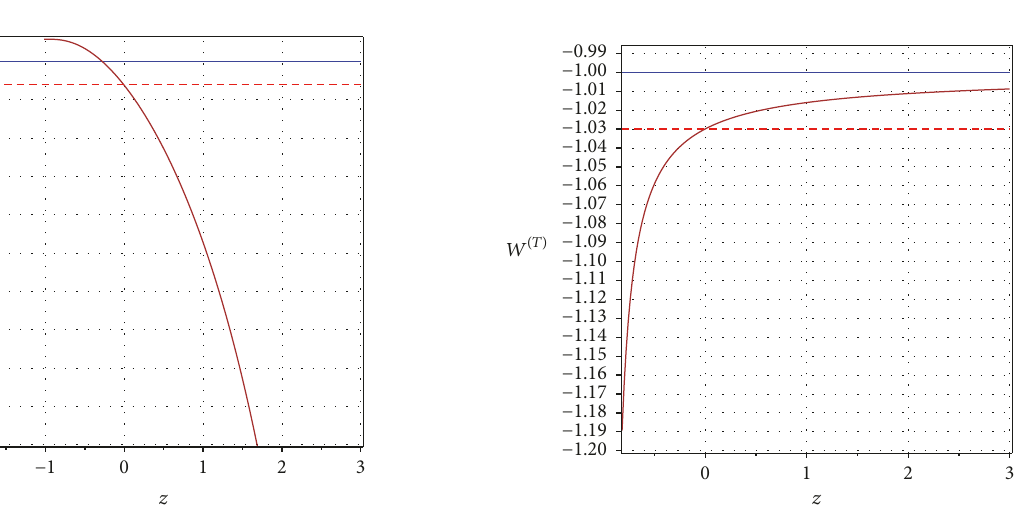
Figure 2: Variation of effective equation of state parameter versus the redshift for 𝑓(𝑇) = 𝑇 + 𝑓 0 (−𝑇) 𝑝 , where the dash lines represent 𝜔 (𝑇) = −1.03 . 0